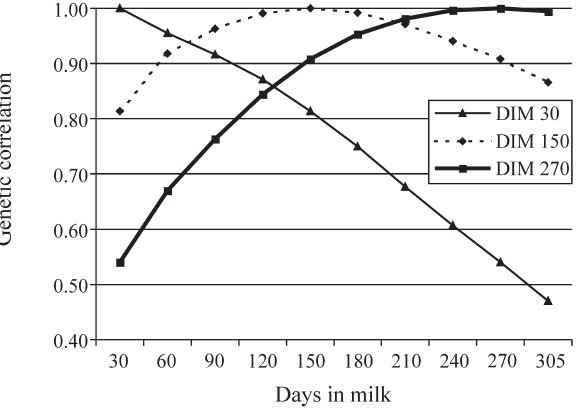
Figure 5 - Genetic correlations between daily milk yield at 30, 150 and 270 days and the other lactation periods obtained by the RRM2